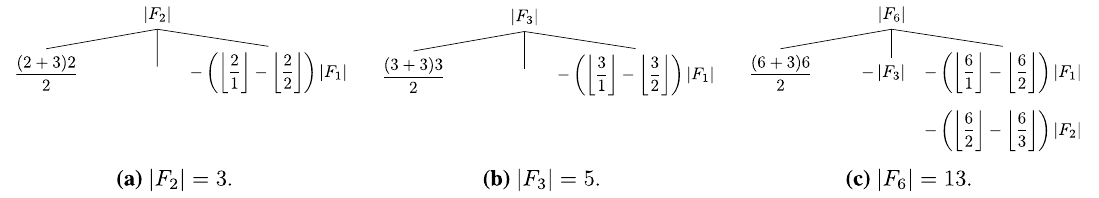
Figure 4. Visualizations of the three instances of formula (5) in the execution of algorithm C when it is called 6 . In this case, the first for-loop of the algorithm invokes the formula to compute F 2 with n as shown in ( a ). = | | F 3 F 6 The second for-loop computes and . The trees for these two terms are shown in ( b ) and ( c ), respectively. | | | | 13 F 6 The result is | | = 6 . This process Figure 4 visualizes the computation performed by algorithm C (i.e., Algorithm 5) for n = uses formula (5) three times. Each tree shown in this figure corresponds to one call to the helper function. The F m root node is the term that the helper function stores in the lookup table. The three branches show the terms | | F m in formula (5) that the function adds to compute the value of . The first for-loop in algorithm C computes | | F 2 and stores its value in the lookup table. Figure 4a visualizes the corresponding instance of formula (5) in | | F 3 F 6 which the middle branch is empty. The second for-loop computes the values of and . The corresponding | | | | F 1 trees are shown in Fig. 4b and c, respectively. Note that there is no tree for because the algorithm stores its | |